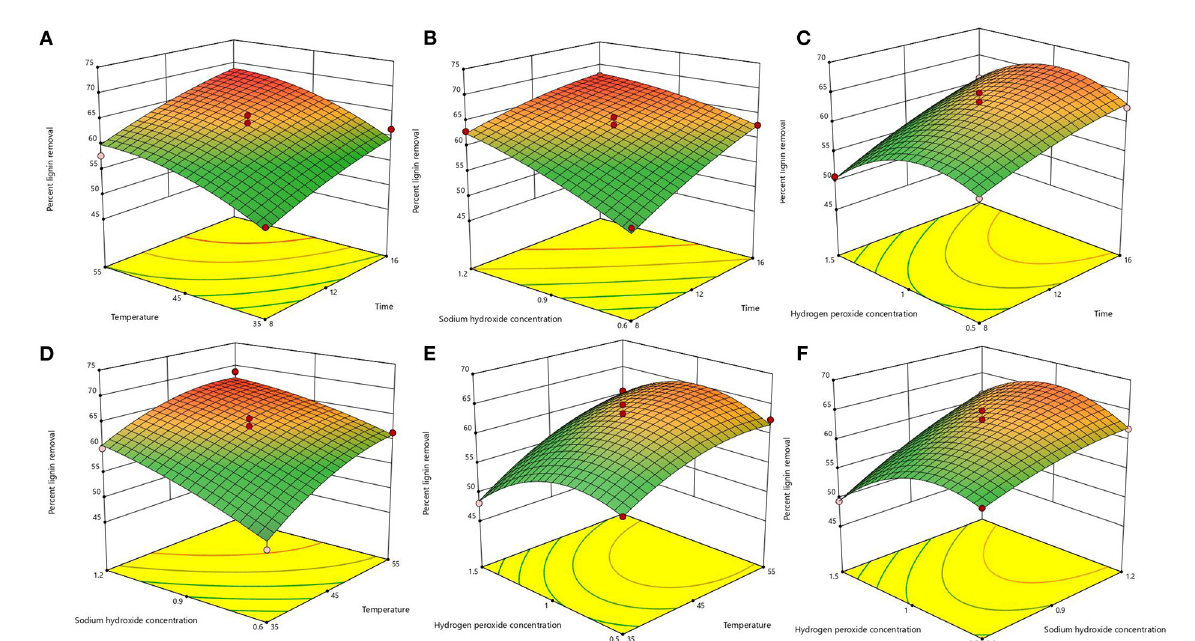
FIGURE1 Response surface plots of the interaction for lignin removal. (A) temperature and time; (B) sodium hydroxide concentration and time; (C) hydrogen peroxide concentration and time; (D) sodium hydroxide concentration and temperature; (E) hydrogen peroxide concentration and temperature; (F) hydrogen peroxide concentration and sodium hydroxide concentration.